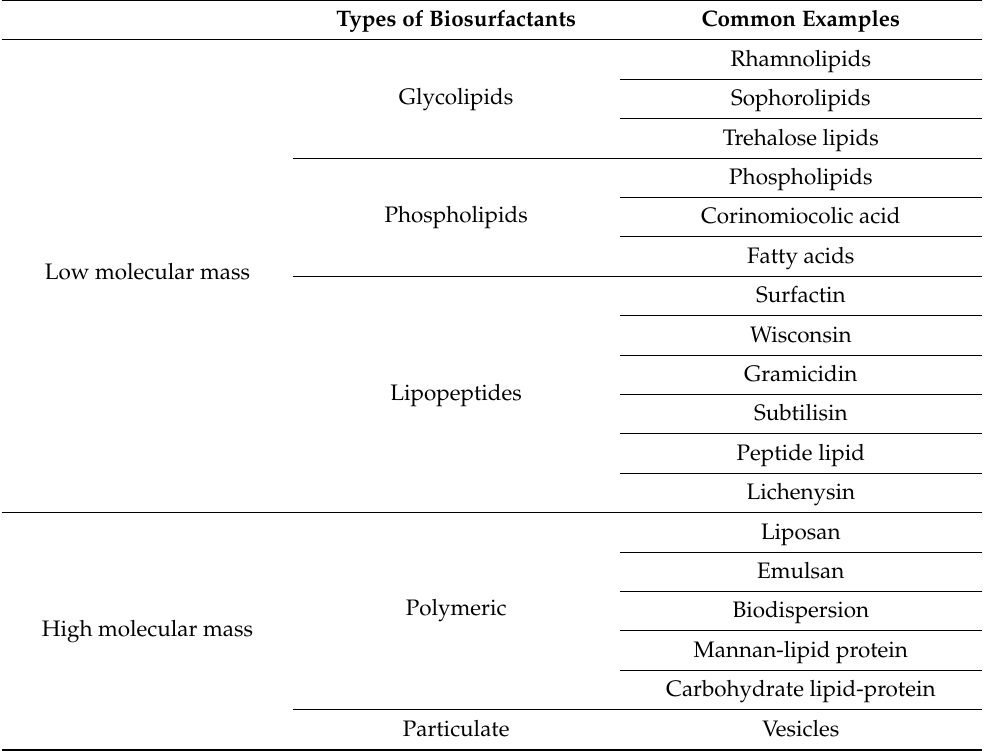
Table 1. Biosurfactant classification and some common